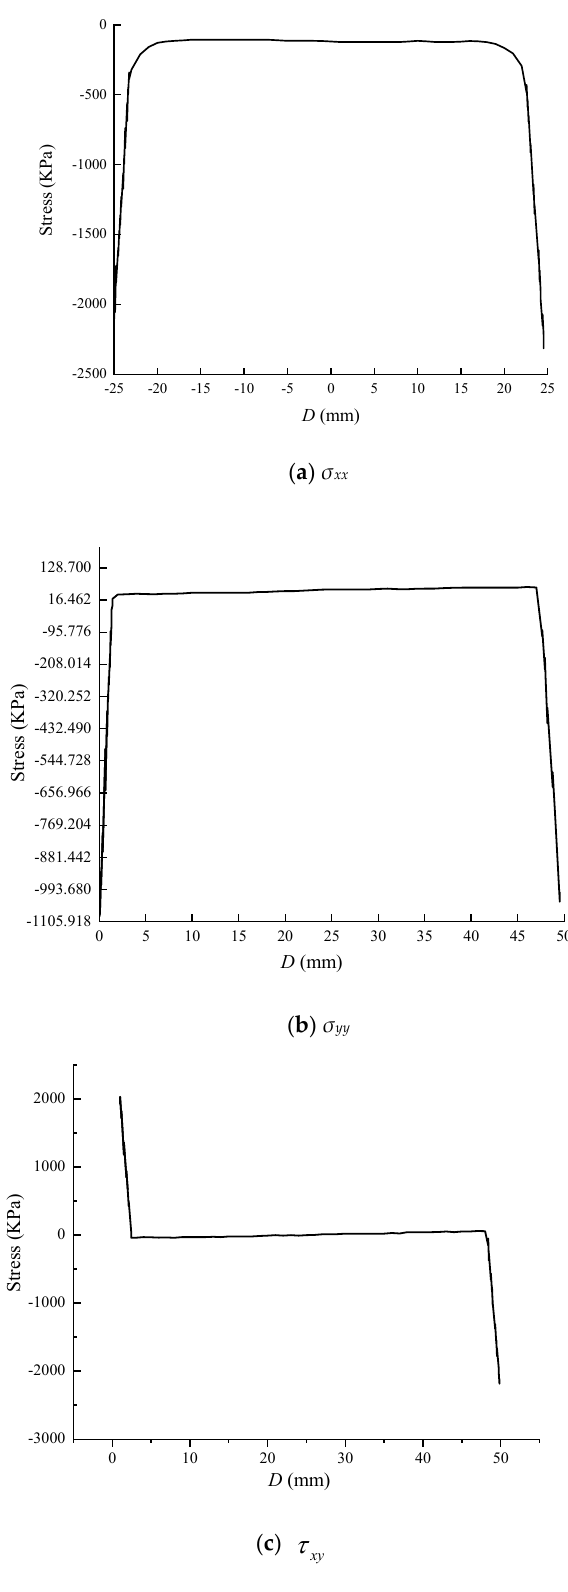
Figure 10. Stress component on the diameter ON.